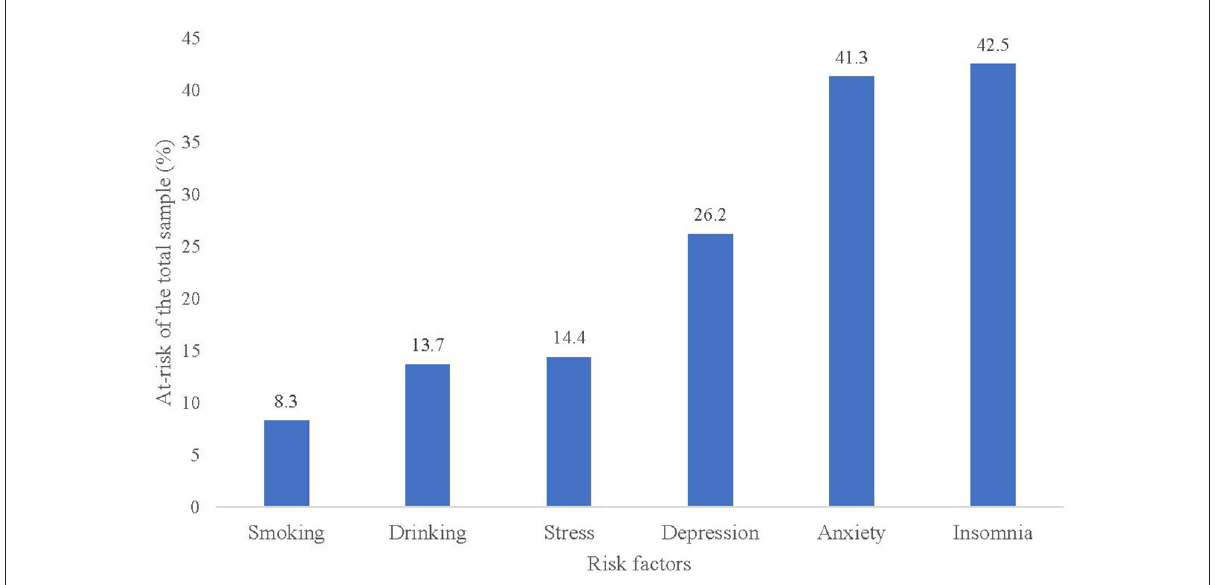
FIGURE1 Prevalence of behavioral health risk factors among